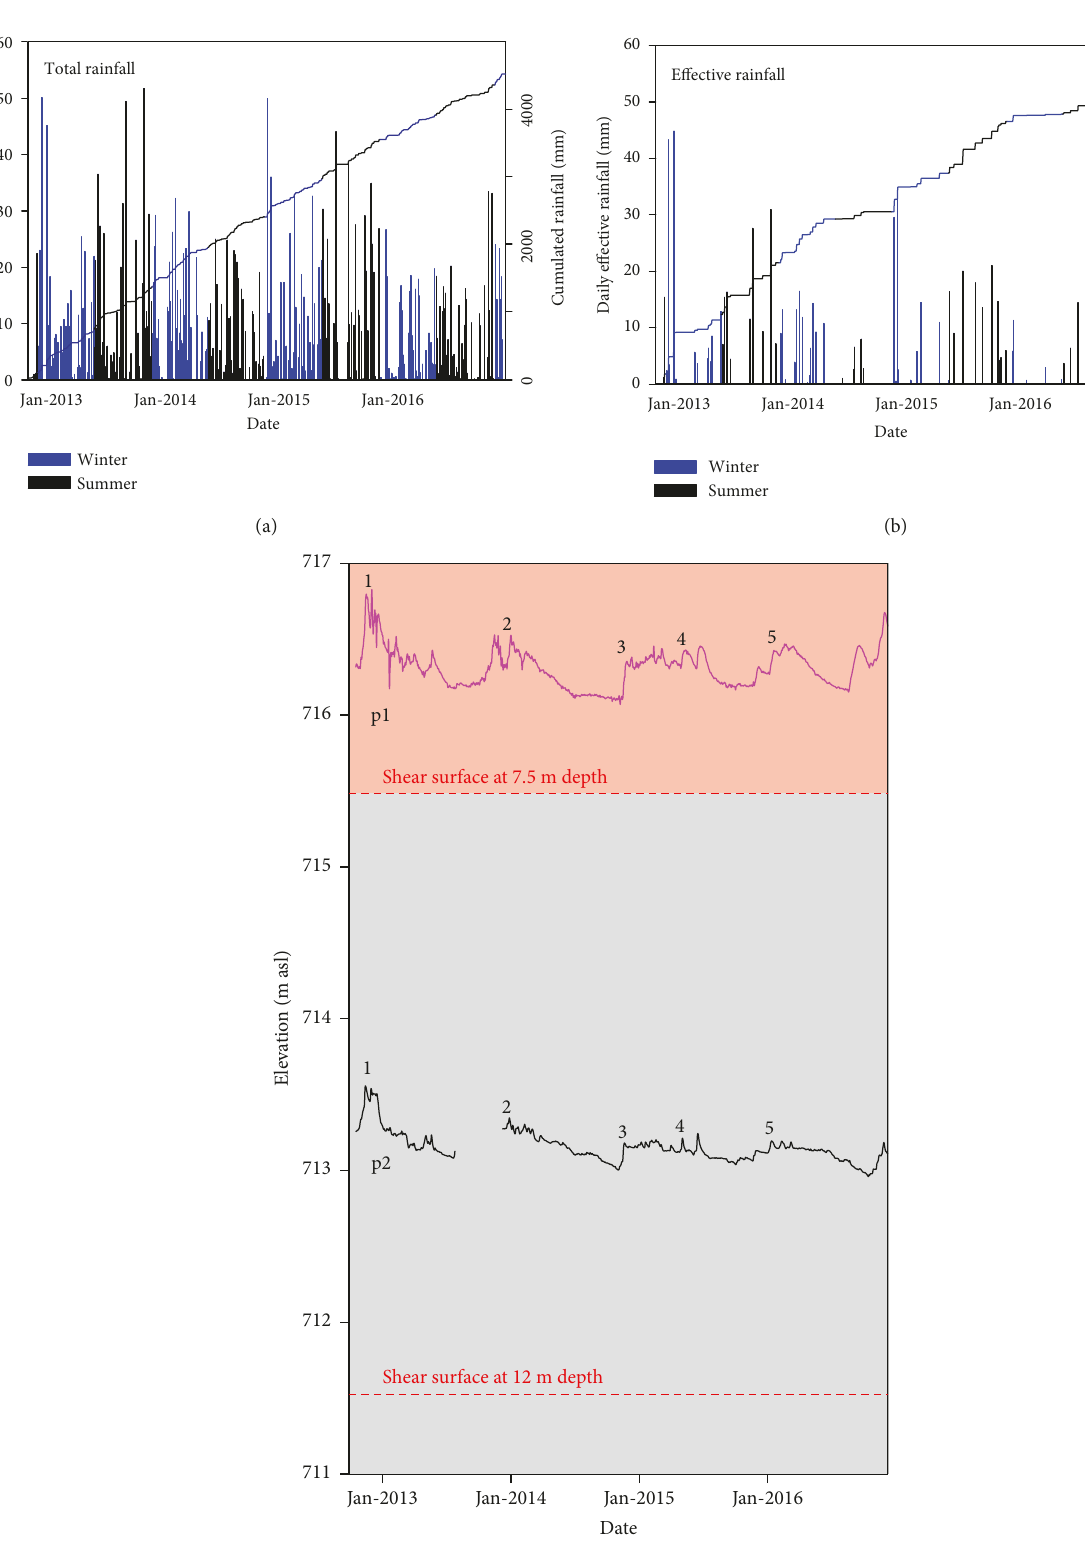
Figure 8: Rainfall and water table time series. (a) Total rainfall, (b) e ff ective rainfall, and (c) water tables. Numbers: see text for